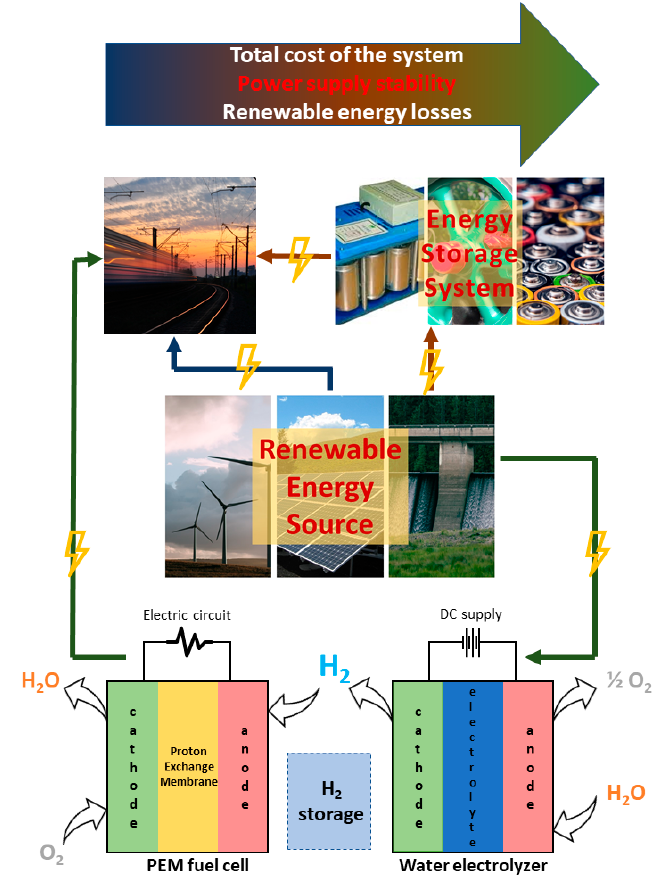
Figure 3. Scheme of the railway electrification by means of RES .